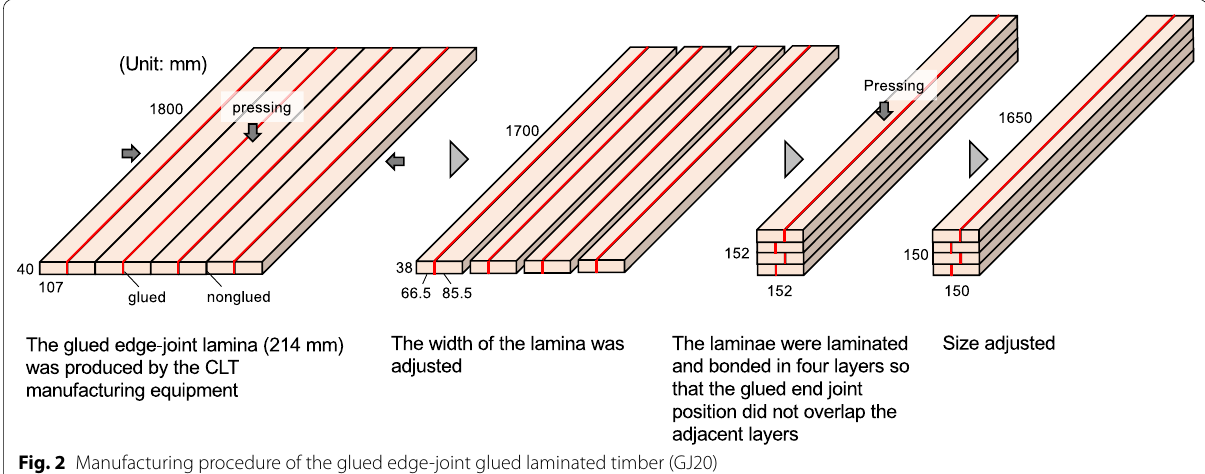
Fig. 2 Manufacturing procedure of the glued edge-joint glued laminated timber (GJ20)